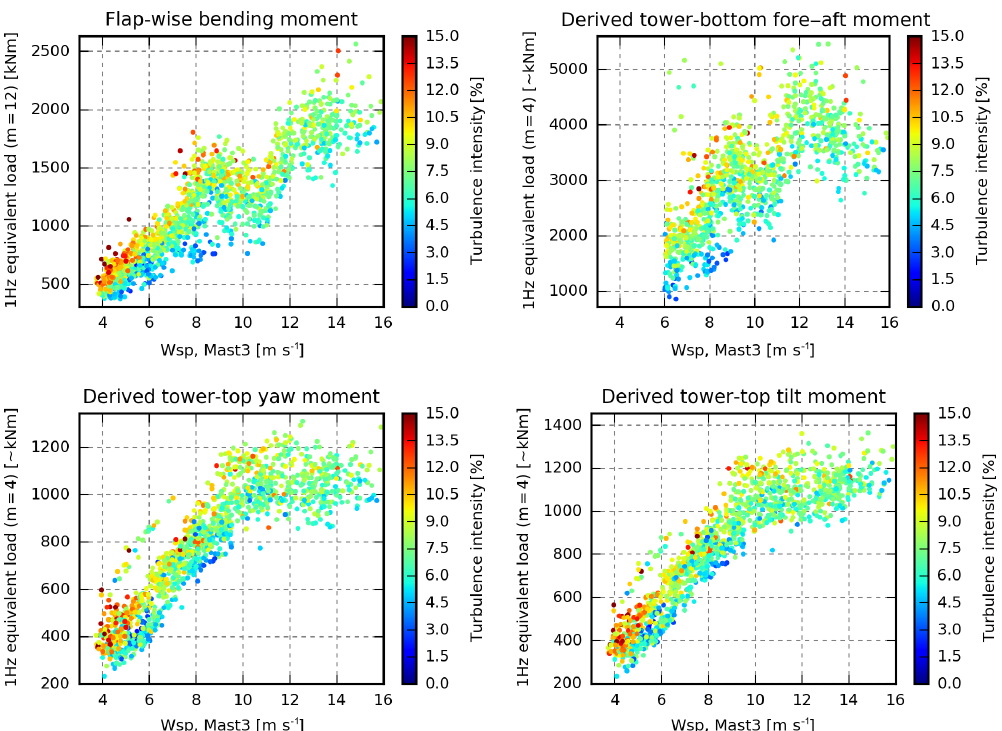
Figure 8. The 1Hz equivalent loads coloured by the magnitude of the turbulence intensity measured at Mast3.